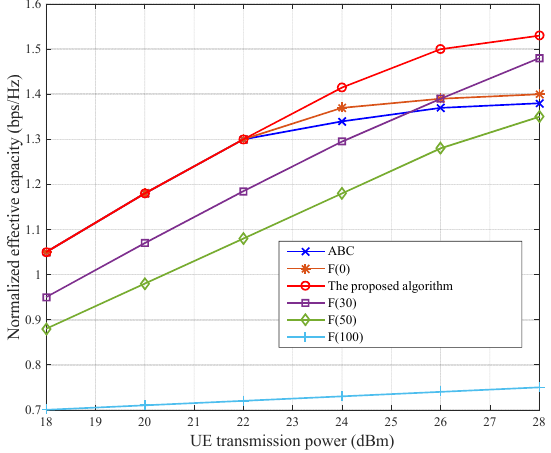
Figure 9. Relationship between normalized effective network capacity and UE-transmit power for unevenly distributed network users.